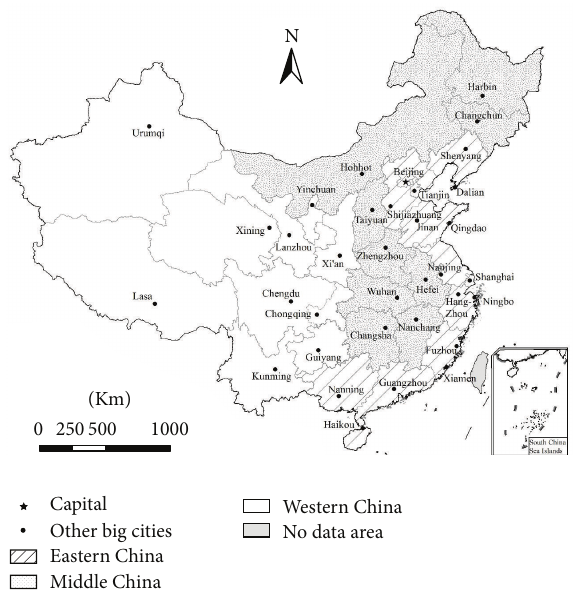
Figure 1: The spatial distribution of the thirty-five big cities in the three regions in